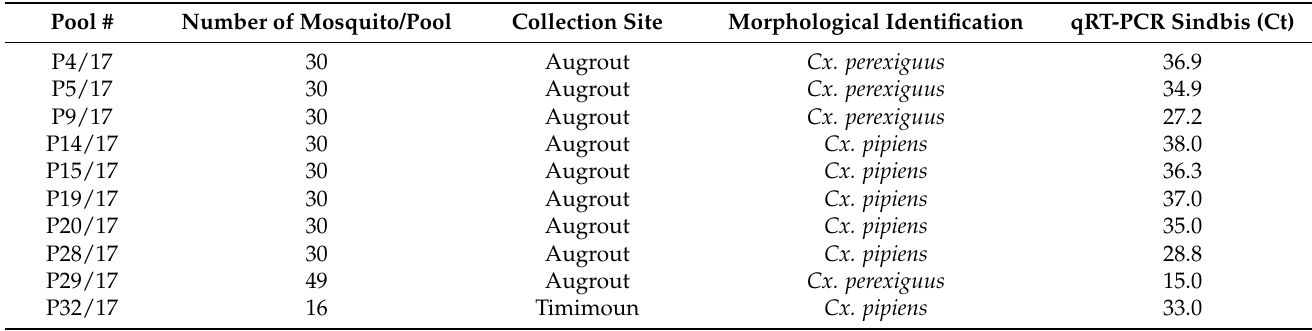
Table 2. Description of the 10 pools containing SINV